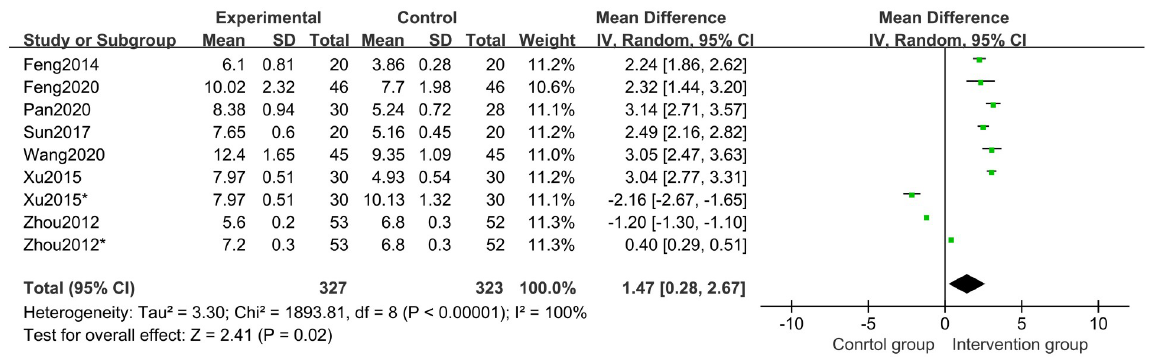
Fig 6. Forest plot of growth velocity.